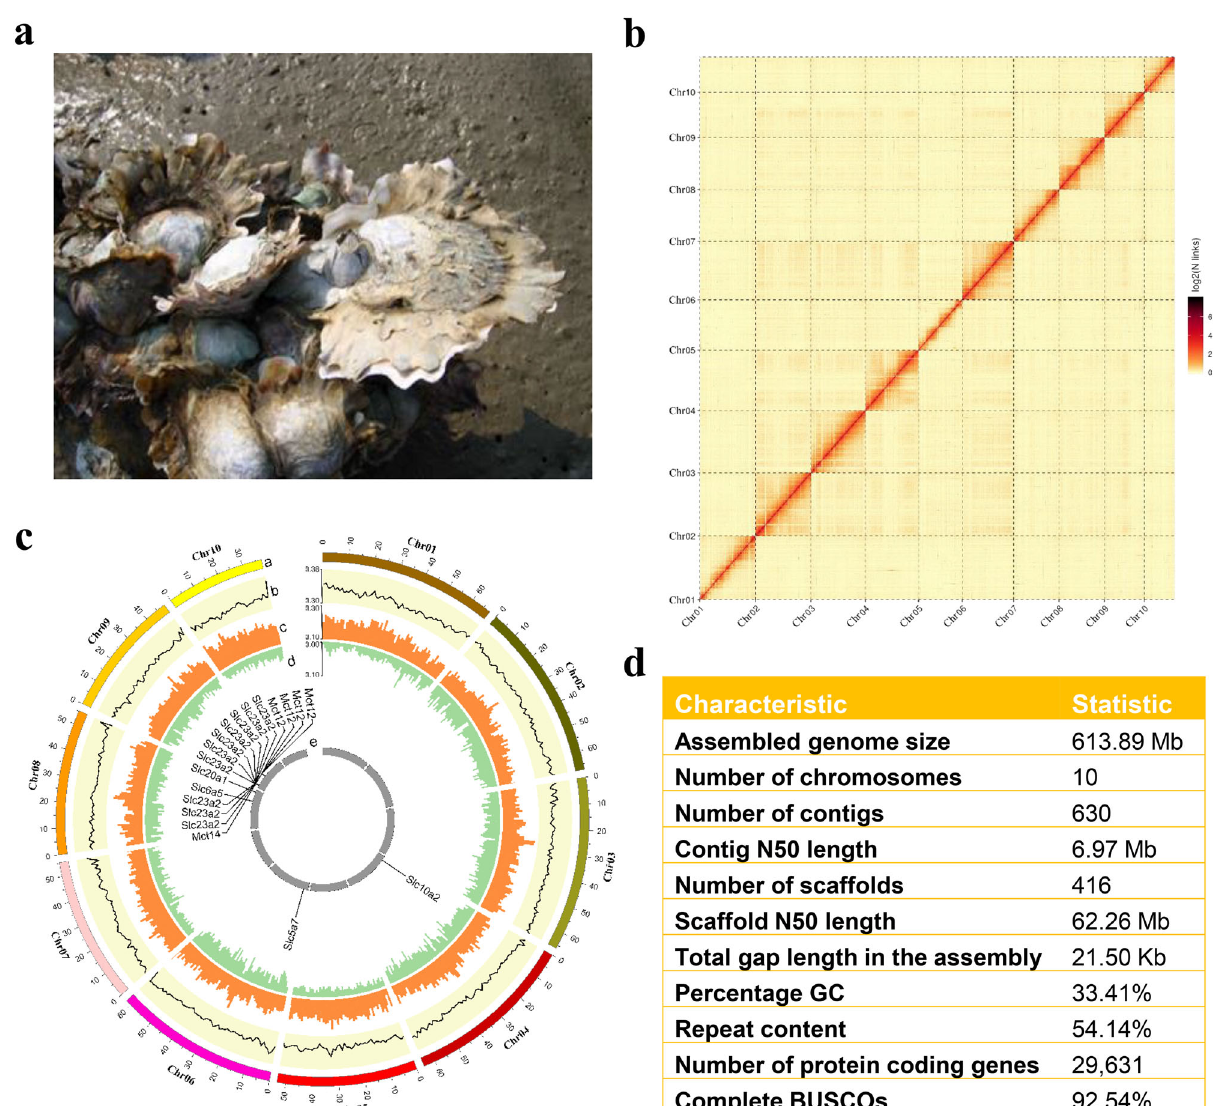
Fig. 1 Chromosome-level assembly of the estuarine oyster Crassostrea ariakensis genome. a Estuarine oyster (photo by Lumin Qian). b Hi-C interaction heatmap showing 10 chromosomes of the estuarine oyster. c CIRCOS plot showing 10 chromosomes (a), the distribution of GC content (b), transposable elements (c), coding sequences (d), and duplicated gene cluster of the solute carrier families showing selection signals (e, also see Supplementary Fig. 13). d Summary statistics of the genome